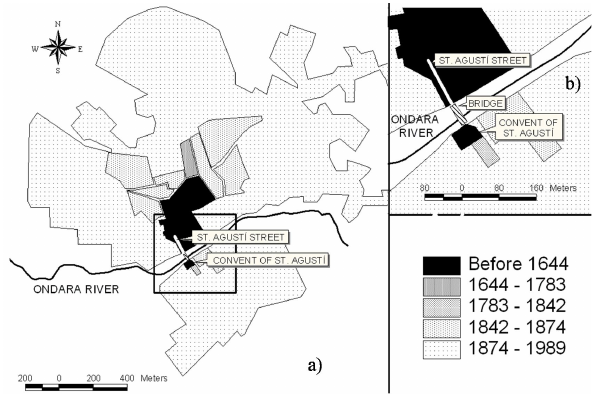
Fig. 1. Location of the Ondara River’s catchment within the Iberian Peninsula (a) and within Catalonia (b) , and map of the catchment itself with the location of the town of T`arrega (c) .